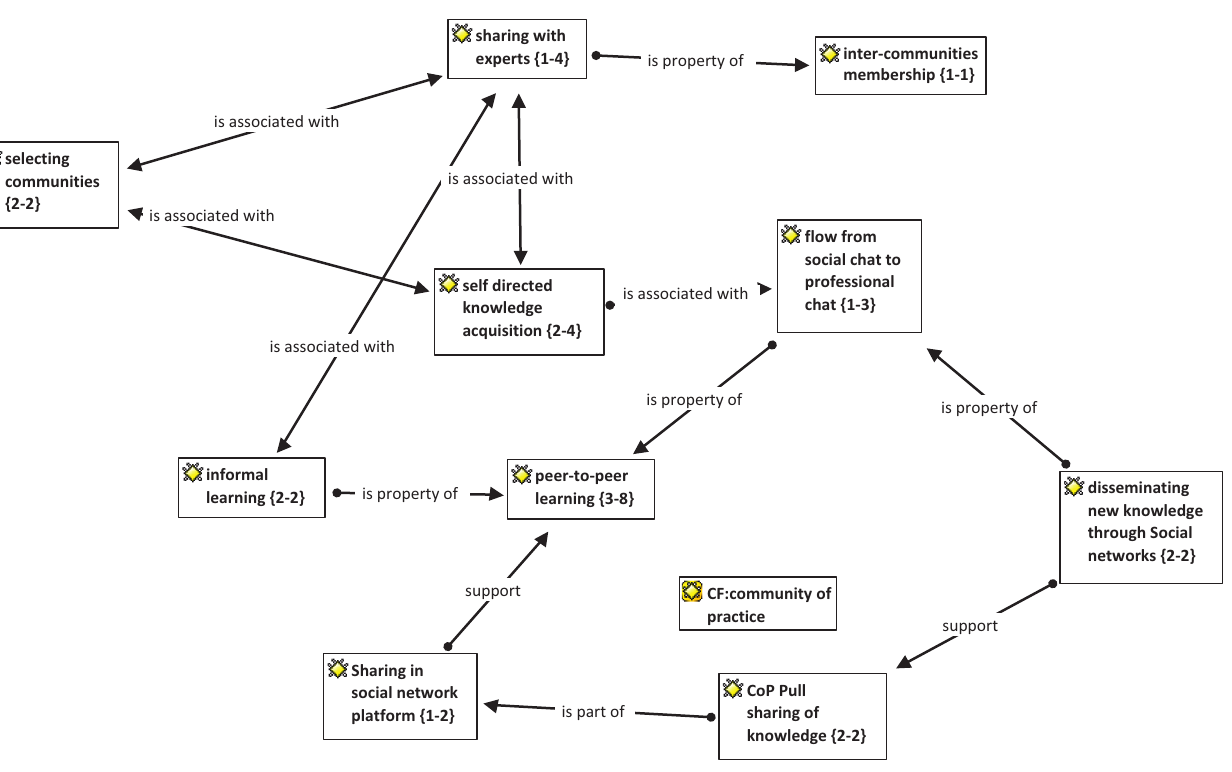
FIGURE 3: Network showing learning through discovery within